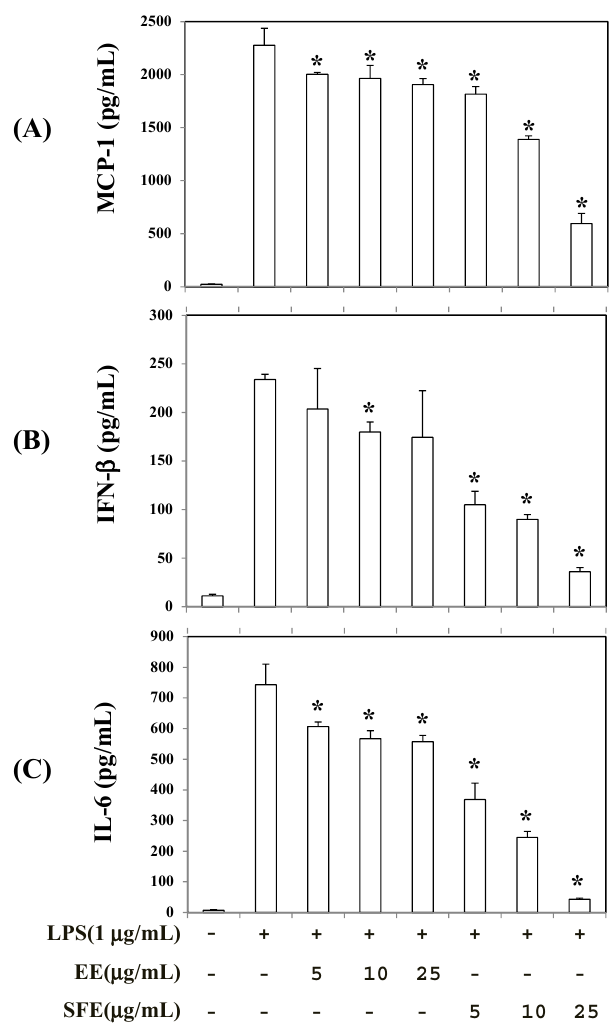
Figure 4. Effects of SFE (50 °C, 400 bar, 3 h, and CO 2 flow rate of 60 mL/min) and EE (shaking incubation for 6 h at 60 °C) on the production of inflammatory mediators in RAW 264.7 cells. RAW 264.7 cells were treated with each extract for 2 h prior to addition of LPS (1 µg/mL) and further incubated for 4 h. MCP-1 ( A ); IFN- β ( B ); and IL-6 ( C ) levels were measured in the cellular medium using an ELISA kit. Data are presented as means ± SD ( n = 3). * p < 0.05 vs. LPS alone − treated group.